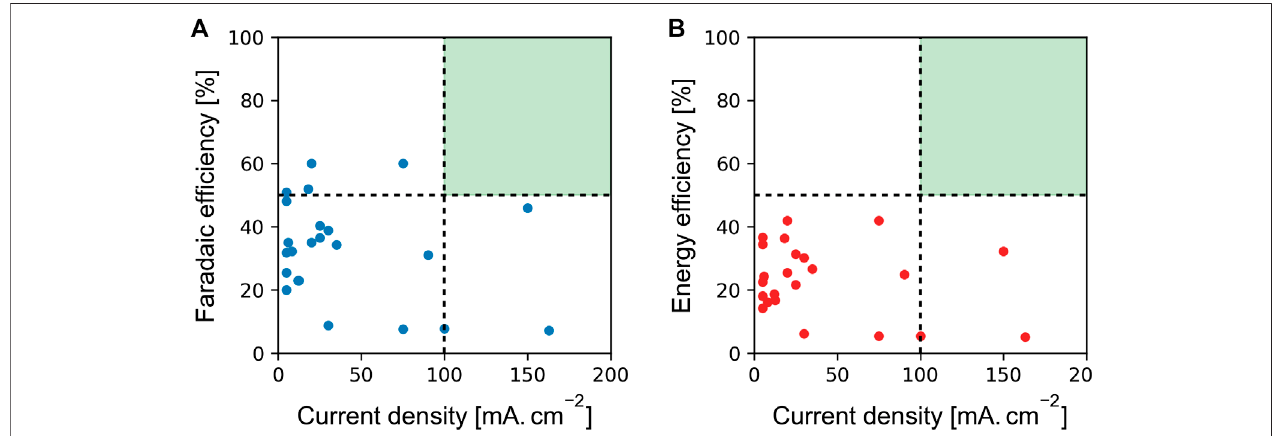
FIGURE 4 | Summary of the electrochemical performance of CO 2 reduction to ethylene from a selection of studies reported in the open literature published in the period from 1986 to 2019: Faradaic ef fi ciencies (A) and energy ef fi ciencies (B) as a function of current density (mA cm − 2 ) (Hori et al., 1985; Kaneco et al., 1999; Ogura et al., 2004; Hori, 2008; Engelbrecht et al., 2016; Ma et al., 2016; Mistry et al., 2016; Wu et al., 2016; Ke et al., 2017; Peng et al., 2017; Gao et al., 2019).